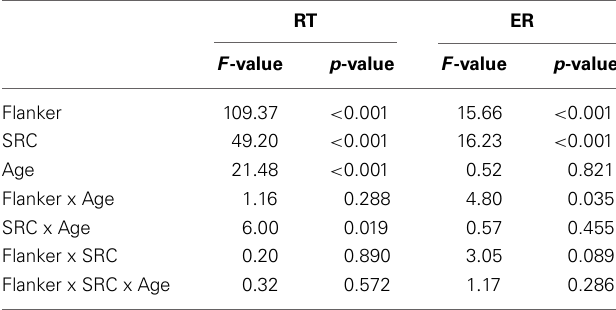
Table 1 | Statistical values of the behavioral data analysis (RT: reaction times; ER: error rates, SRC: stimulus response